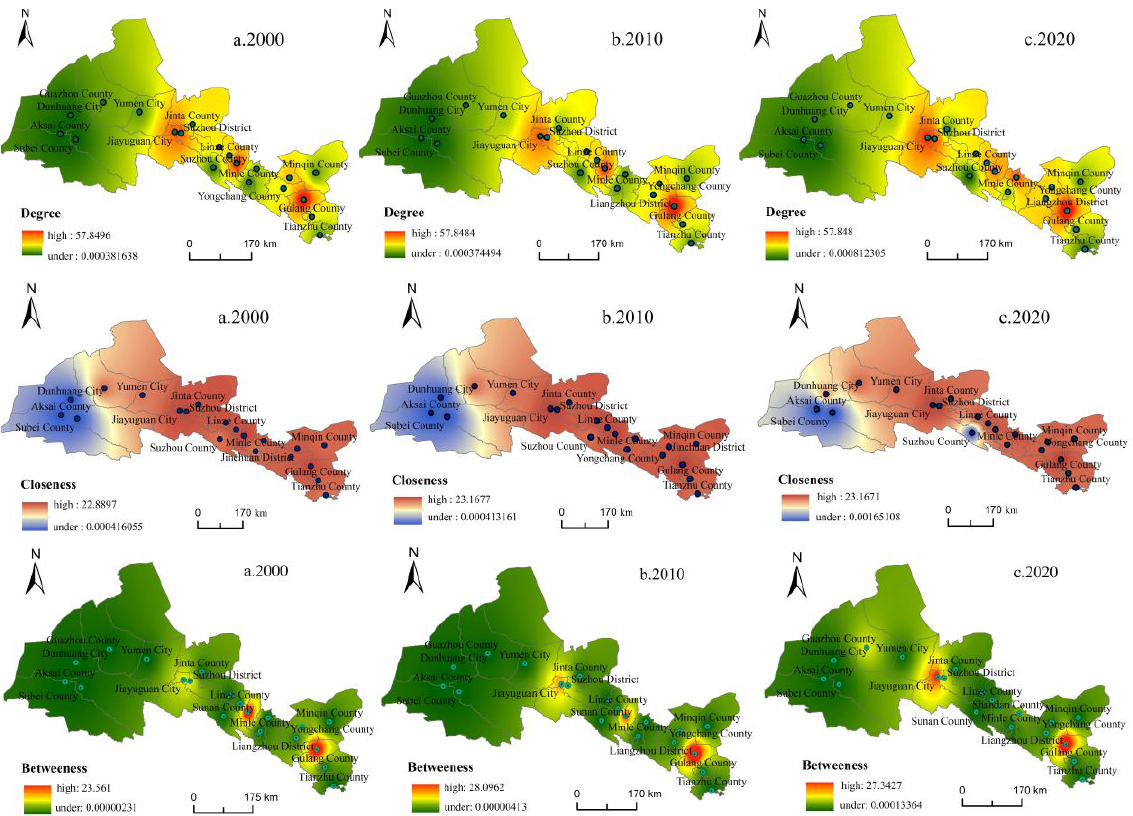
Figure 7. Spatial distribution of centrality of the Hexi Corridor in 2000, 2010, and 2020.